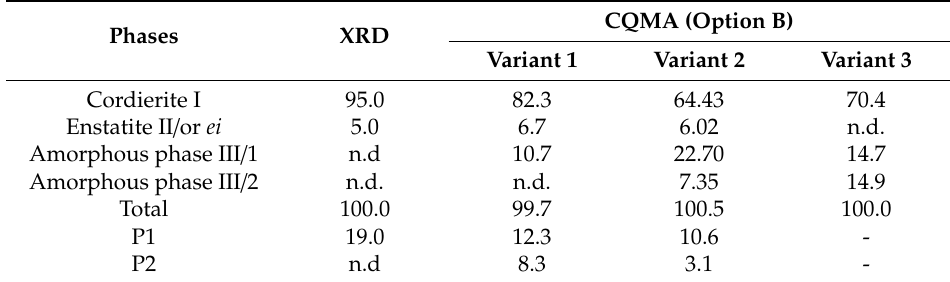
Table 4. Percentages of determined phases (wt%) using the CQMA method for variants 1–3 and the XRD (RIR) method.